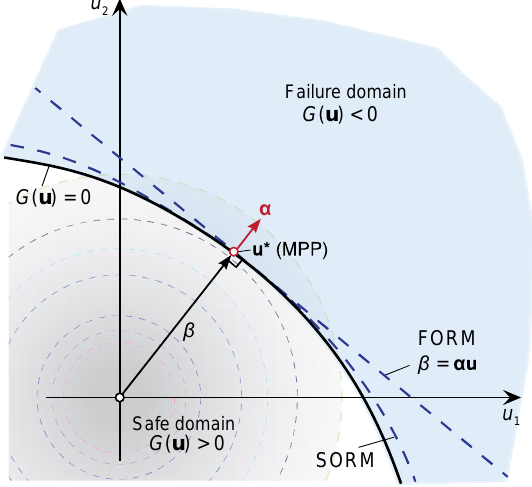
Figure 1. Illustration of the first-order reliability method (FORM) and second-order reliability method (SORM) for a reliability problem.